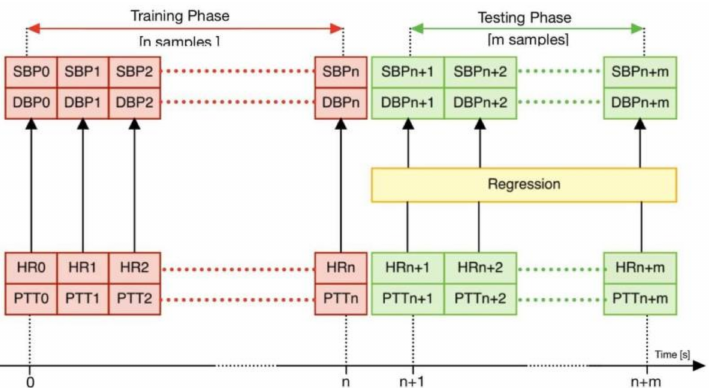
Figure 14. Regression process with signals from the SHIMMER